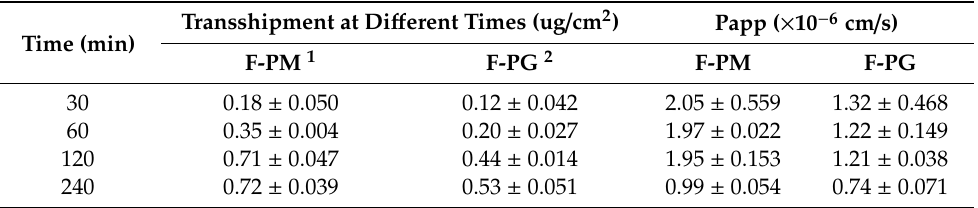
Table 6. Translocation of F-PM and F-PG at di ff erent times.